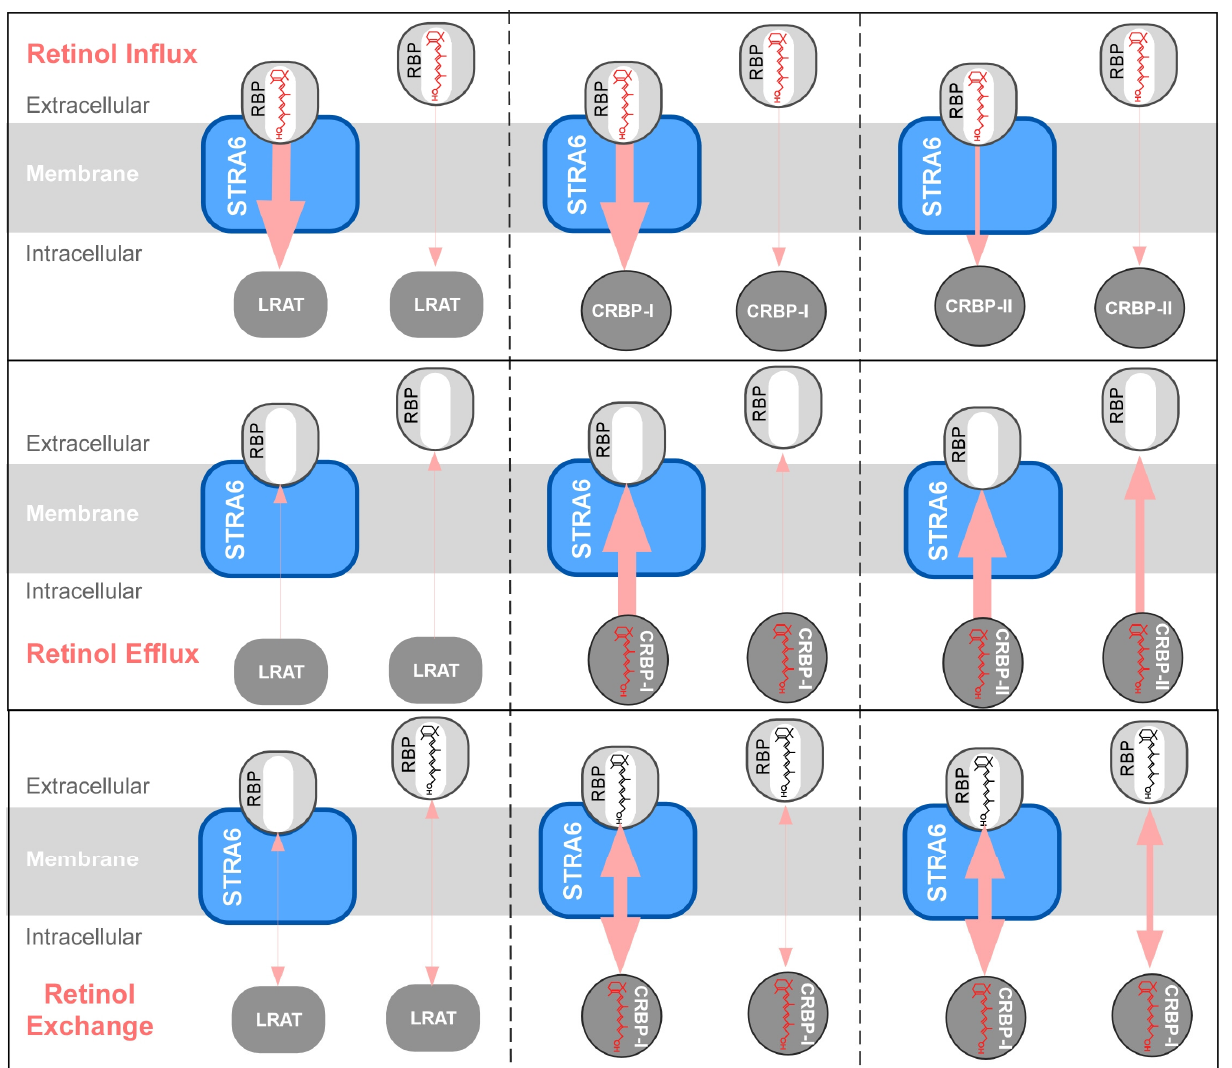
Figure 5. Schematic diagrams comparing the activities of LRAT, CRBP-I, and CRBP-II in STRA6-dependent or STRA6-independent retinol influx, efflux, and exchange. In retinol exchange diagrams, intracellular and extracellular retinol molecules are drawn in different colors (for diagrams involving LRAT, retinyl ester is not drawn). The directions of retinol transport are indicated by the light red arrows. The efficiency of retinol transport is indicated by the thickness of each